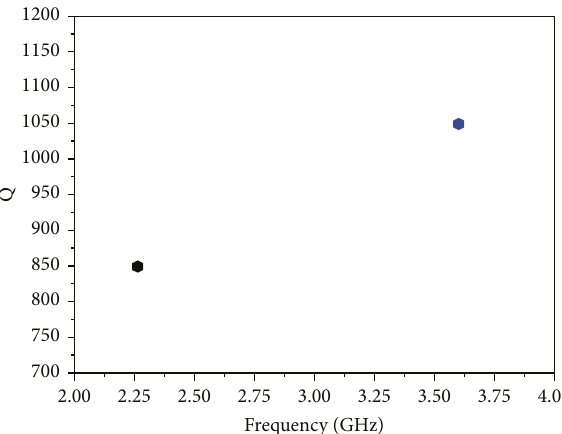
Figure 7: Te quality factor ( Q ) fgure comparison between gra- phene and AlN, black spot stands for graphene and blue spot stands for AlN in our sensor.